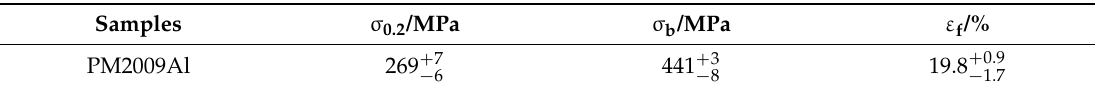
Table 2. Room temperature tensile properties of 5, 7, and 9 vol% TiC x /2009Al composites with ( a ) 0 h,